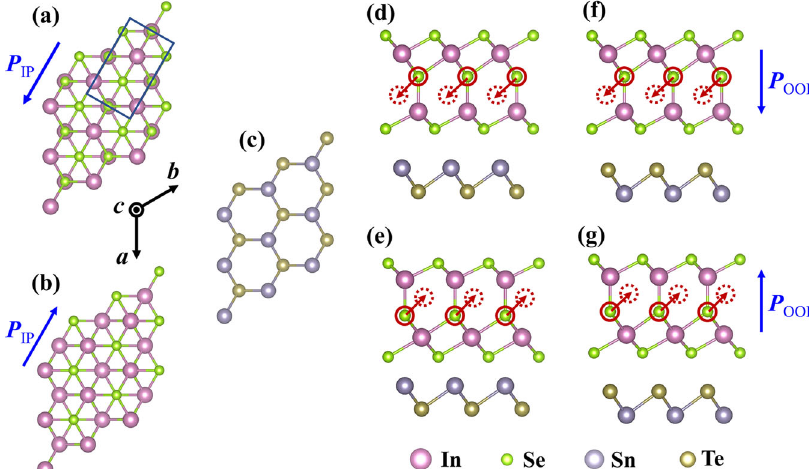
Fig. 1 Structural con fi gurations of the heterostructures. a , b The top views of In 2 Se 3 with downward ( P ↓ ) and upward ( P ↑ ) polarizations. c The top view of SnTe. d – g The side views of the four types of In 2 Se 3 /SnTe heterostructures as seen against the a -axis in a – c . The seen monolayers and heterostructures are 3 × 3 expanded along the a - and b -axes relative to the unit cells for better visualization. Blue arrows represent the directions of the IP and OOP polarizations of In 2 Se 3 . The red arrows in d – g indicate the moving directions of the central layer Se atoms if the In 2 Se 3 are reversed from the current polarization states to the opposite polarization